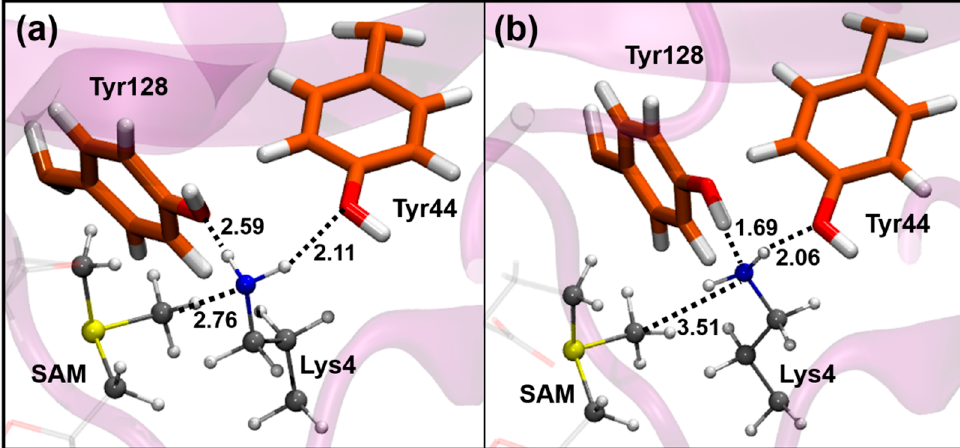
Figure 5. Role of the proper configuration for the interaction between Tyr44 and Tyr128 with Lys4. When both tyrosines act as proton acceptors provide a C···N interaction distance with for ( a ) corresponding to T-conf-2 leads to a Δ E ≠ of 10.5 kcal/mol, while for ( b ) the T-conf-15 system shows the consequences when Tyr128 acts as a proton donor forming a shorter interaction with Lys4 leading to a Δ E ≠ of 29.3 kcal/mol. Table 4. Mean values for some selected interaction distances between the cofactor and the substrate with the catalytic site, for both M3RA and MLL3 at their respective RS and TS. Distances are in Å.